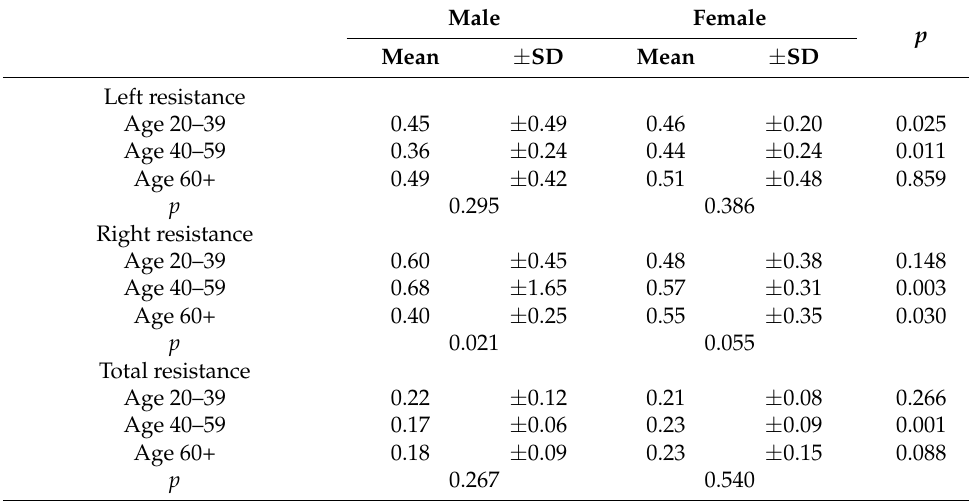
Table 1. Nasal inspiratory resistance (Pa/cm 3 /s) at a fixed pressure of 75 Pascal. Male